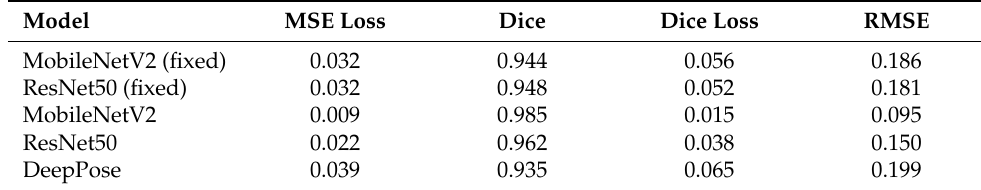
Table 4. Values of accuracy